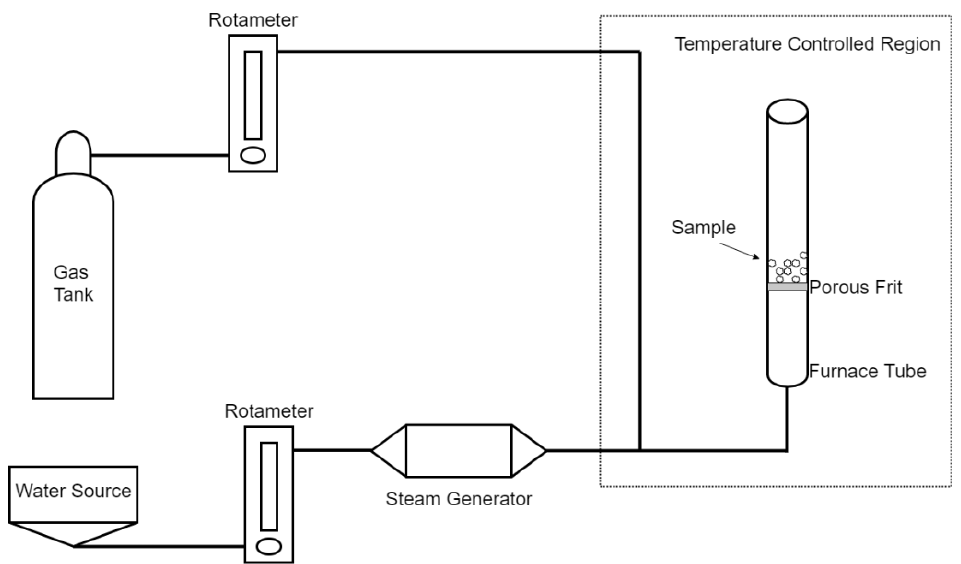
Figure 3. Furnace schematic depicting sources of gasses and steam flowing into a temperature-con- trolled